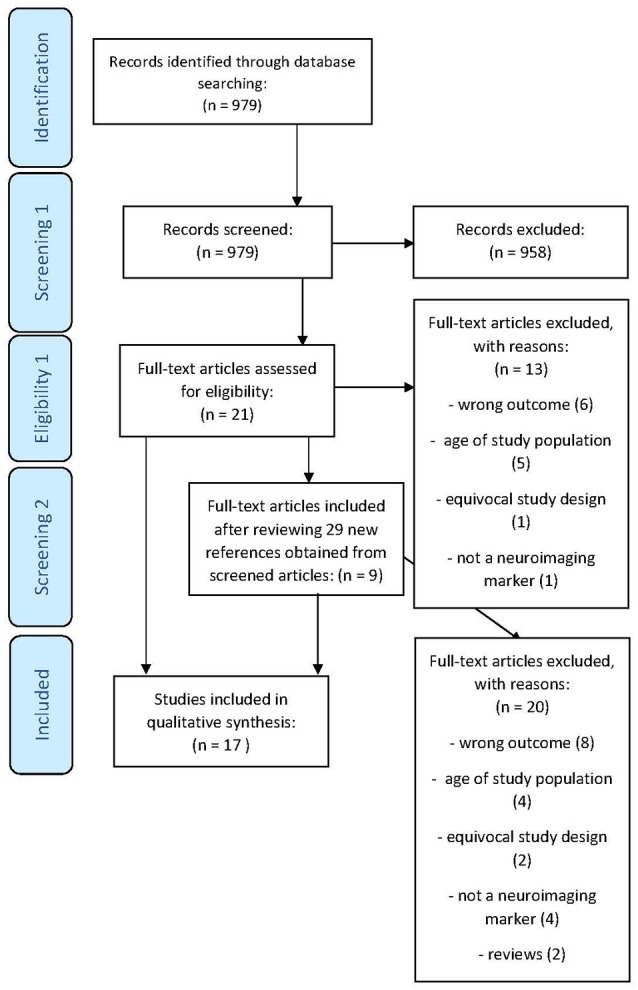
PRISMA flow diagram.